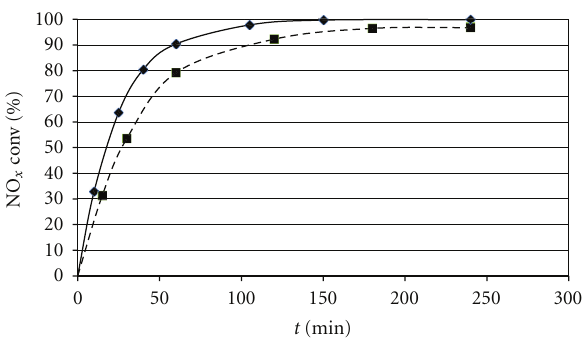
Figure 3: Comparison between P25 ( (cid:2) ) and 1077 ( (cid:3) ) in the NO x photodegradation in a batch